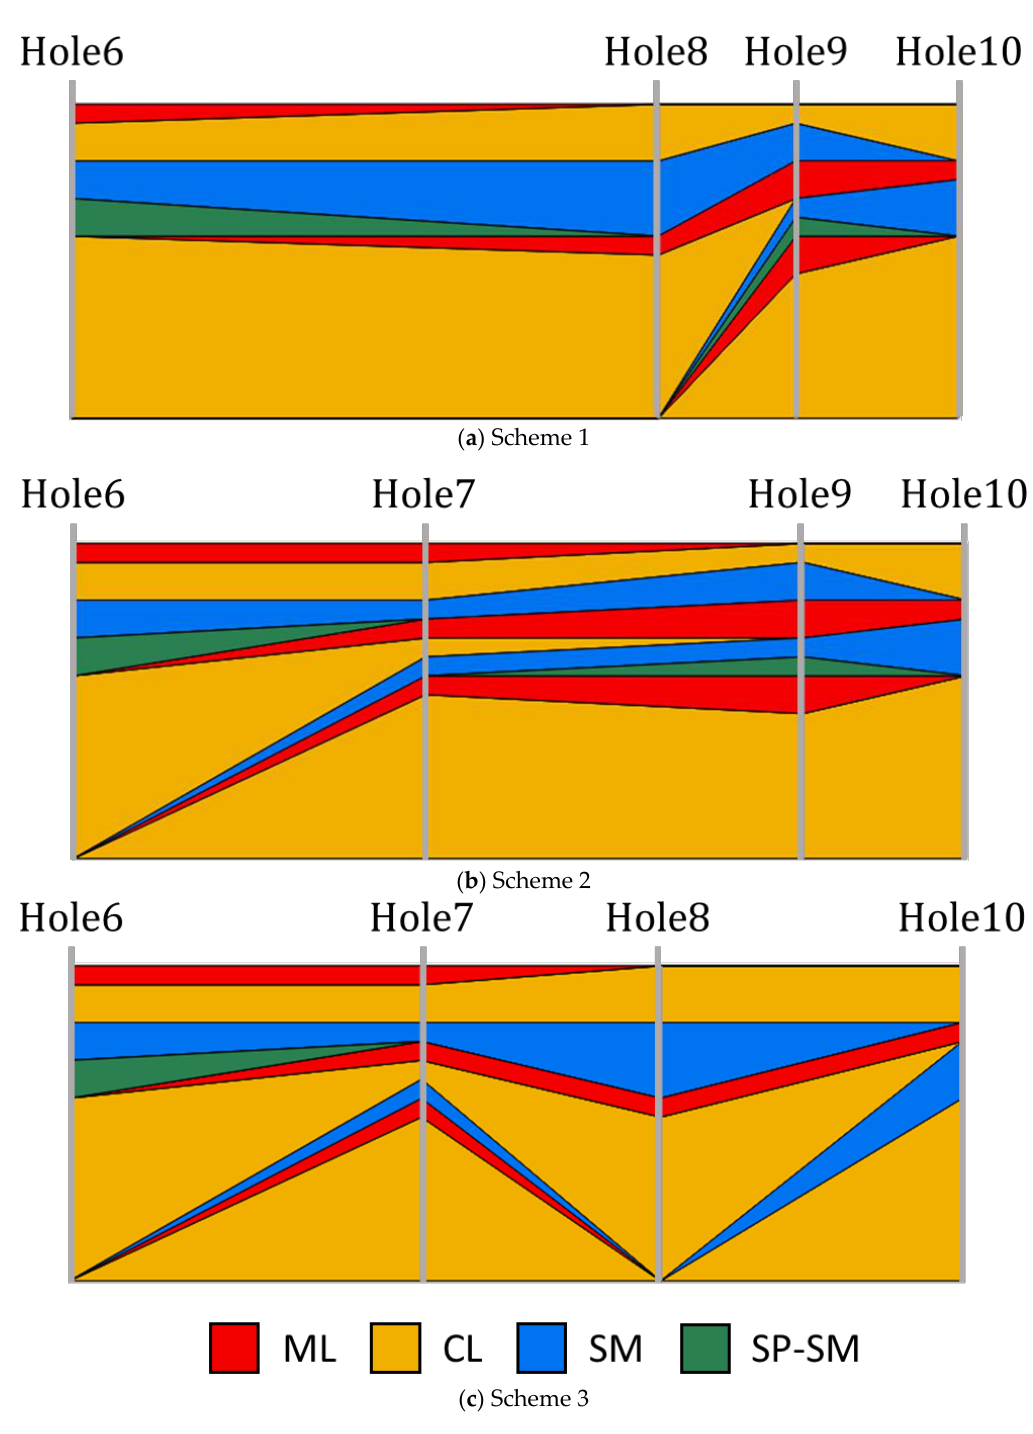
Figure 7. Stratigraphic profiles generated through Kriging interpolation.